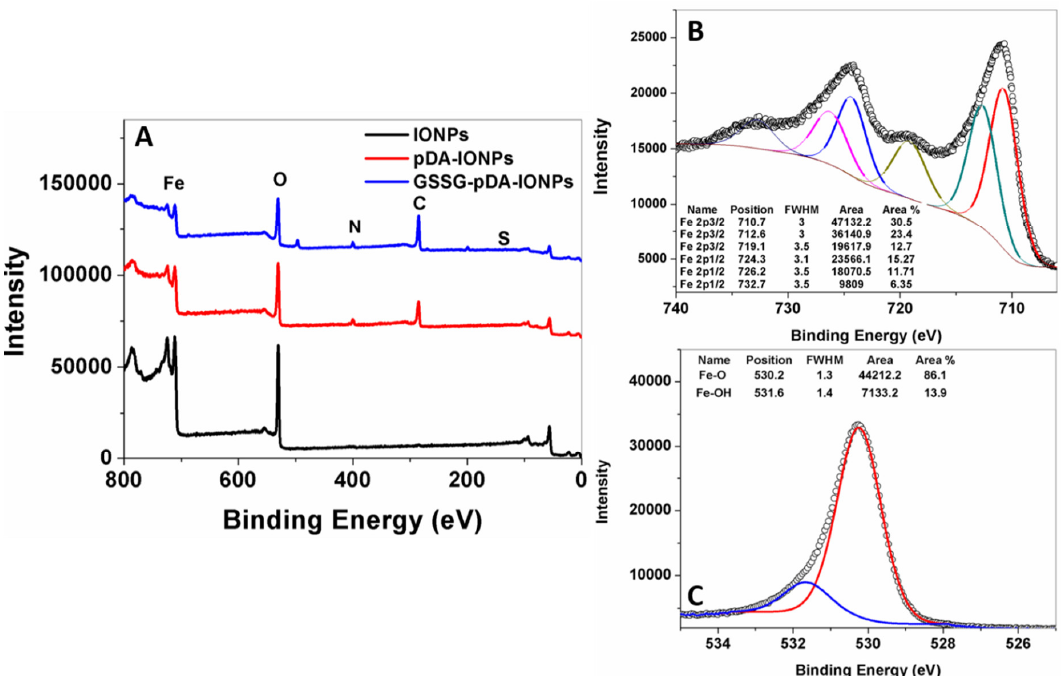
Figure 4. ( A ) X-ray photoelectron spectroscopy (XPS) survey spectra of the prepared nanoparticles with the fitted peaks of ( B ) Fe (2p); and ( C ) oxygen (1s) of bare IONPs. Table 1. XPS elemental analysis (atomic percentage) of the prepared nanoparticles. Samples